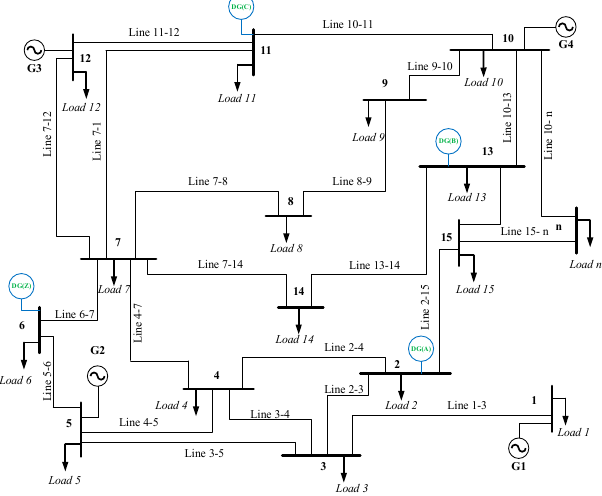
Figure 1. General electrical system.